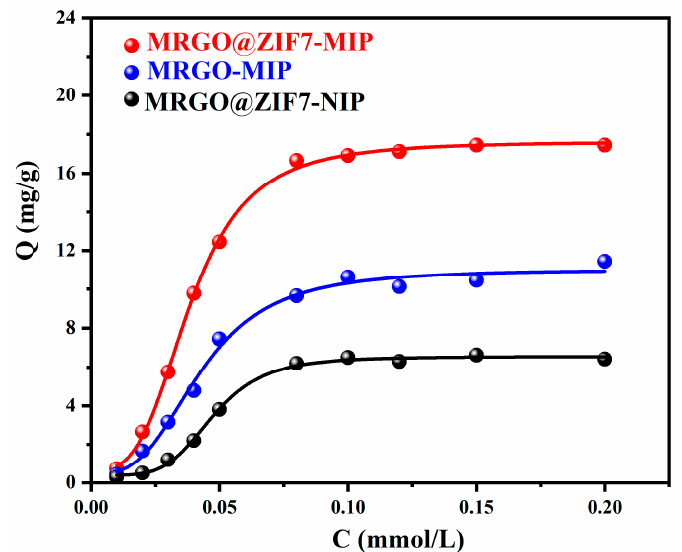
Figure 7. Adsorption isotherms of MRGO@ZIF7-MIP, MRGO-MIP, and MRGO@ZIF7-NIP for BPA. Other conditions: 10 mg sorbent, 10 mL sample solution of 0.08 mmol L − 1 BPA, temperature 25 °C.